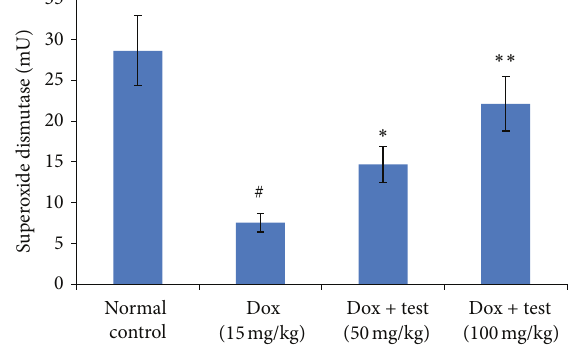
Figure 6: Effect of test compound on superoxide dismutase levels in heart tissue homogenate in rats treated with doxorubicin. # 𝑃 < 0.001 versus normal control; ∗∗ 𝑃 < 0.01 versus dox; ∗∗∗ 𝑃 < 0.001 versus dox.